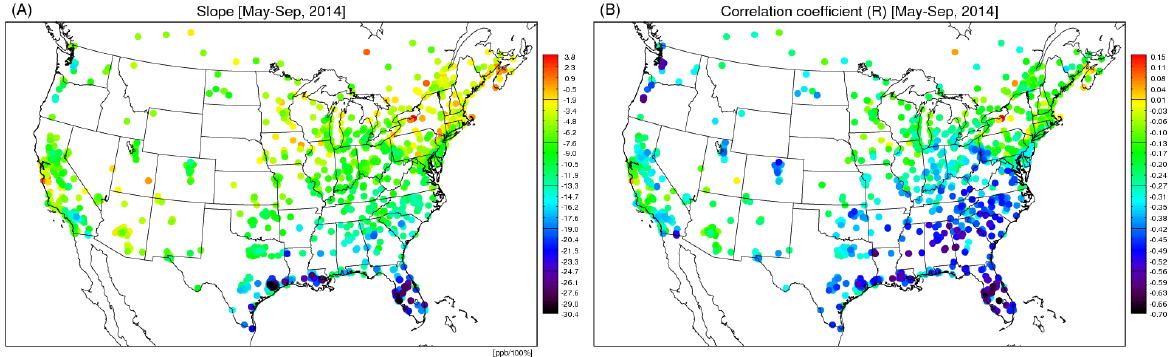
Figure 4. Spatial distributions of (a) slope and (b) correlation coefficient of linear regression between MODIS CF and MDA8 ozone.